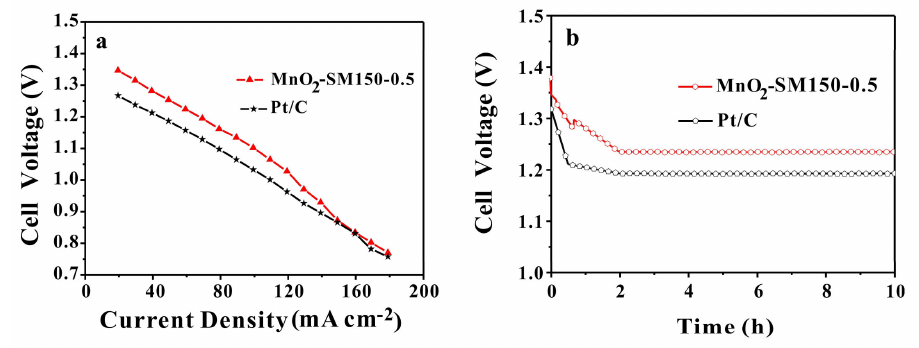
Figure 9. ( a ) Polarization curves of Al–air batteries and ( b ) discharge curves at a constant current density of 50 mA cm − 2